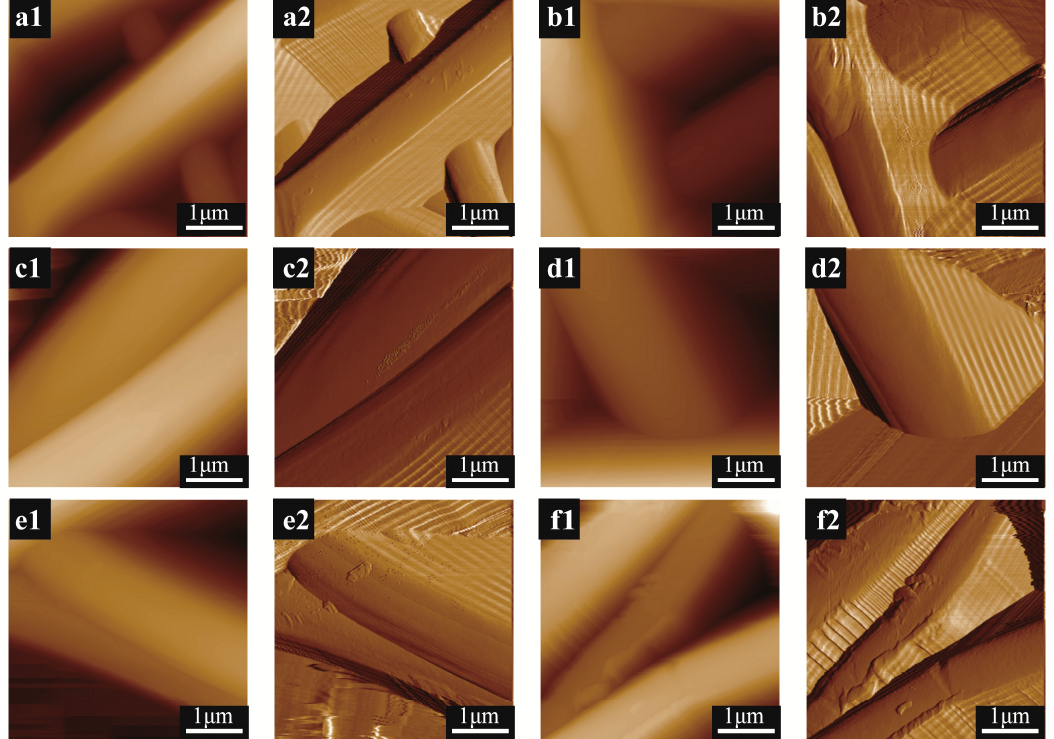
Figure 4. Height ( a1 , b1 , c1 , d1 , e1 , f1 ) and Peak Force Error ( a2 , b2 , c2 , d2 , e2 , f2 ) images of PLA nanofibers with different mineralization time: ( a1 , a2 ) 0-day; ( b1 , b2 ) 1-day; ( c1 , c2 ) 3-day; ( d1 , d2 ) 5-day; ( e1 , e2 ) 7-day; ( f1 , f2 ) 21-day.